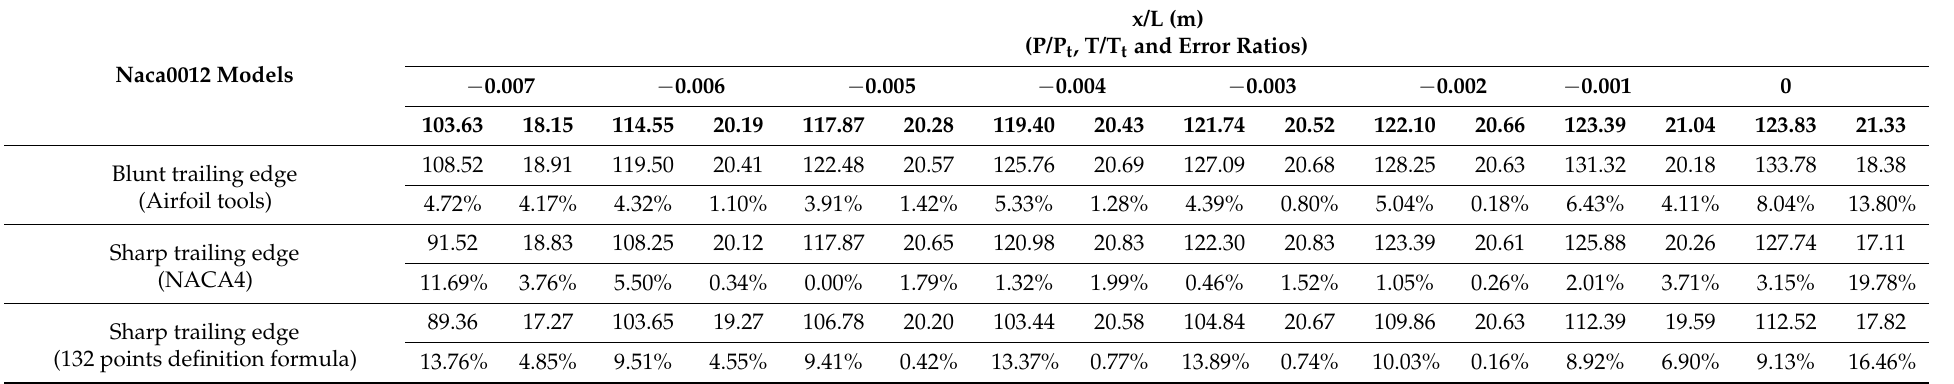
Table 11. Numerical results of P/P t , T/T t and Error Ratios adopting SST k-omega and far-field distance of 20